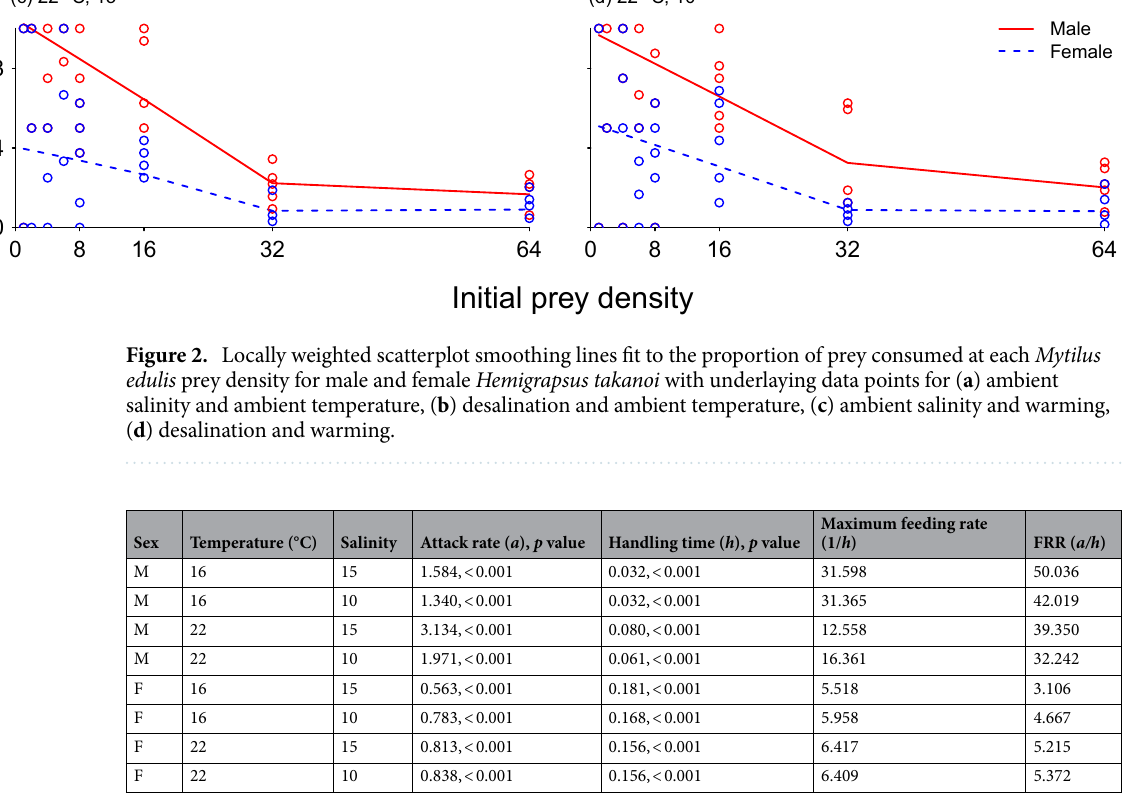
Table 3. Male (M) and female (F) Hemigrapsus takanoi functional response parameter estimates ( a,h ), maximum feeding rate (1/ h ) and functional response ratio (FRR: a/h ) for all experimental treatment groups towards Mytilus edulis